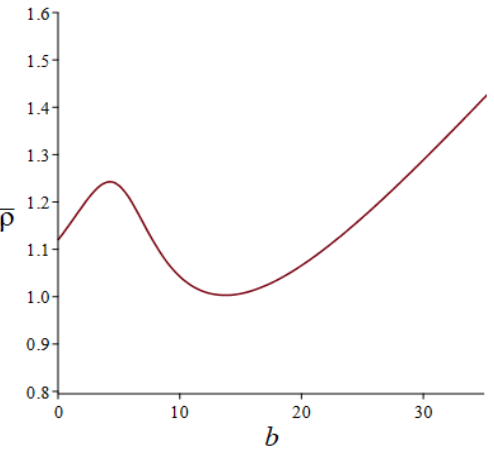
Figure 4. Effect of toxin release rate by TPP population on maximum amplitude ¯ ρ .